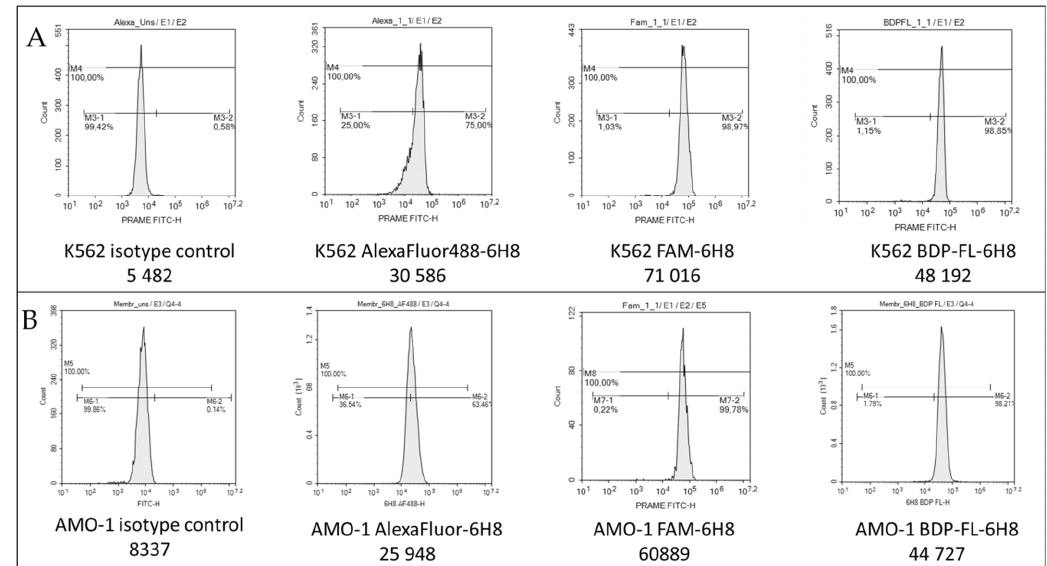
Figure 4. Flow cytometry of model cell lines K562 ( A ) and AMO-1 ( B ).